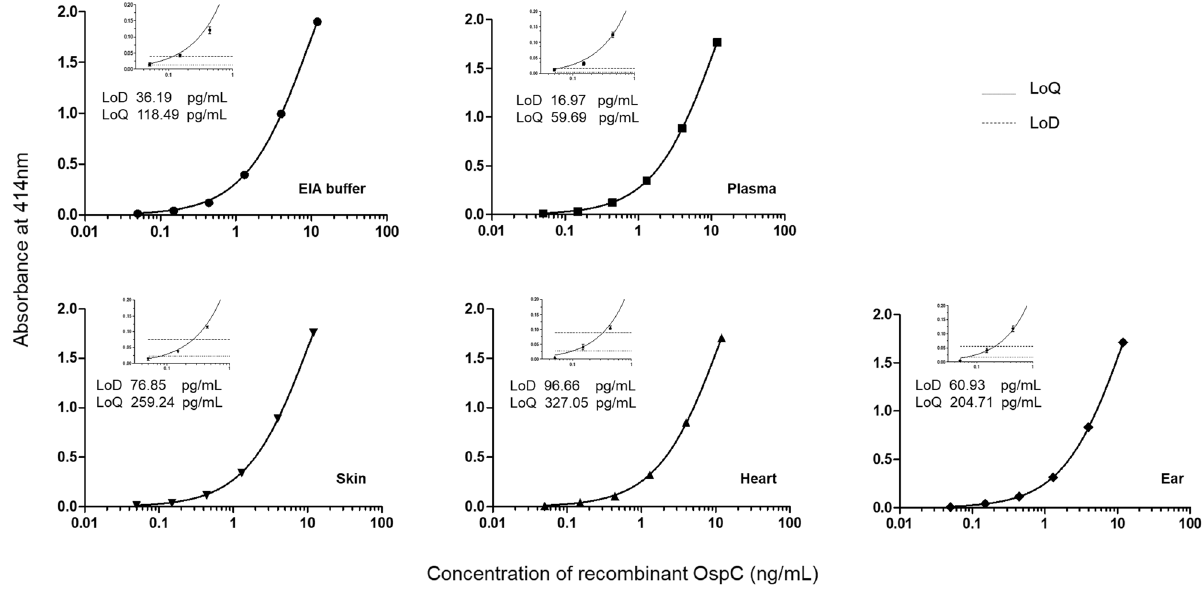
Figure 3. Standards curves obtained with solid phase-immobilized epitope immunoassay (SPIE-IA) in various complex matrices. Serial dilutions of OspC protein were performed in EIA buffer and in different mouse tissues or fluid. The theoretical limit of detection (LoD) and limit of quantification (LoQ) are indicated for each tissue. Thin dotted and dashed horizontal lines represent absorbance reached for the detection limit (three standard deviations) and quantification limit (10 standard deviations), respectively. Data points represent mean values obtained from three independent experiments each including a duplicate and error bars represent standard deviations (n = 6). The nonspecific binding was subtracted from